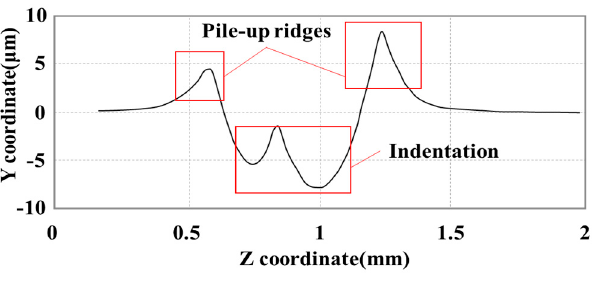
Figure 2. Simulated LPB surface profile with pile-up obtained. (Reprinted with permission from Ref. [16]; published by Elsevier, 2013).